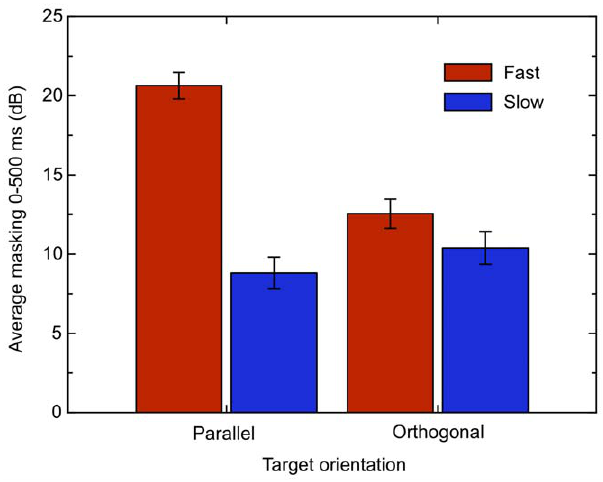
Figure 3. Results from a repeated-measures one-way ANOVA analysis of the averaged threshold elevations for each condition during the masking period. Error bars show + 1 standard error.